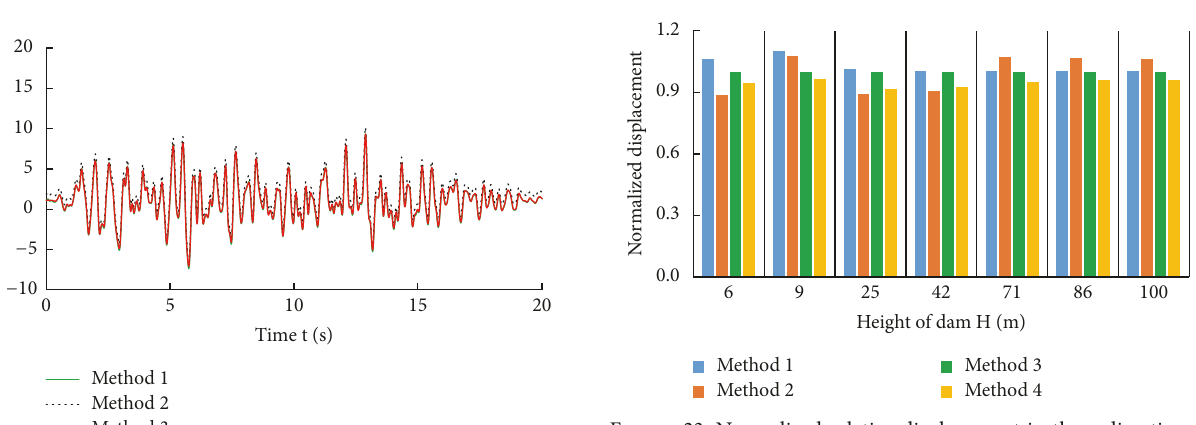
Figure 23: Normalized relative displacement in the z direction at different heights of the